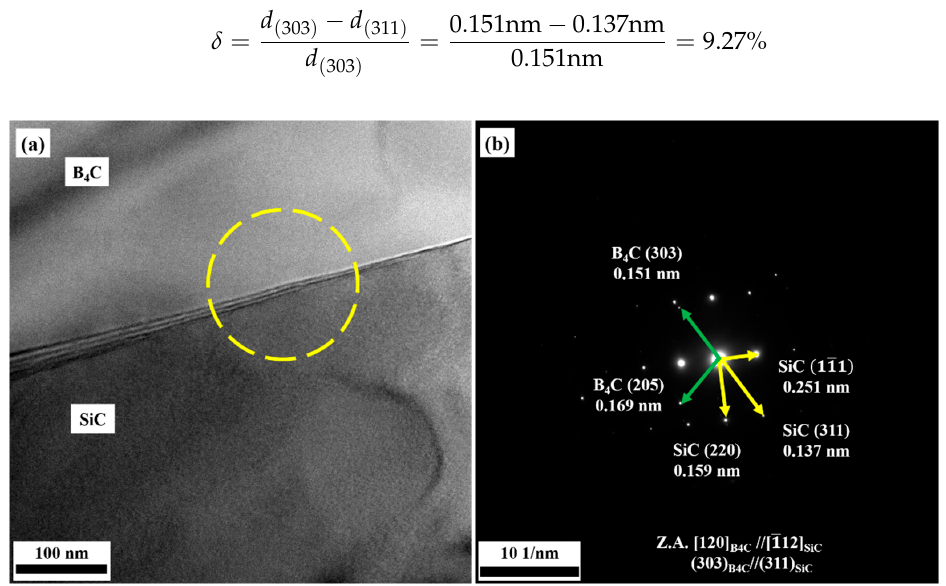
Figure 8. Interface between B 4 C and SiC. ( a ) Bright field TEM image, ( b ) SAED pattern.